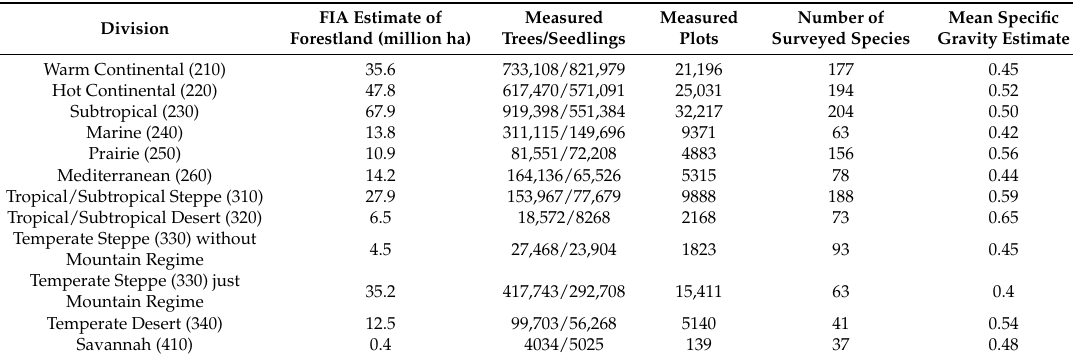
Table 1. Sample properties and results by Ecological